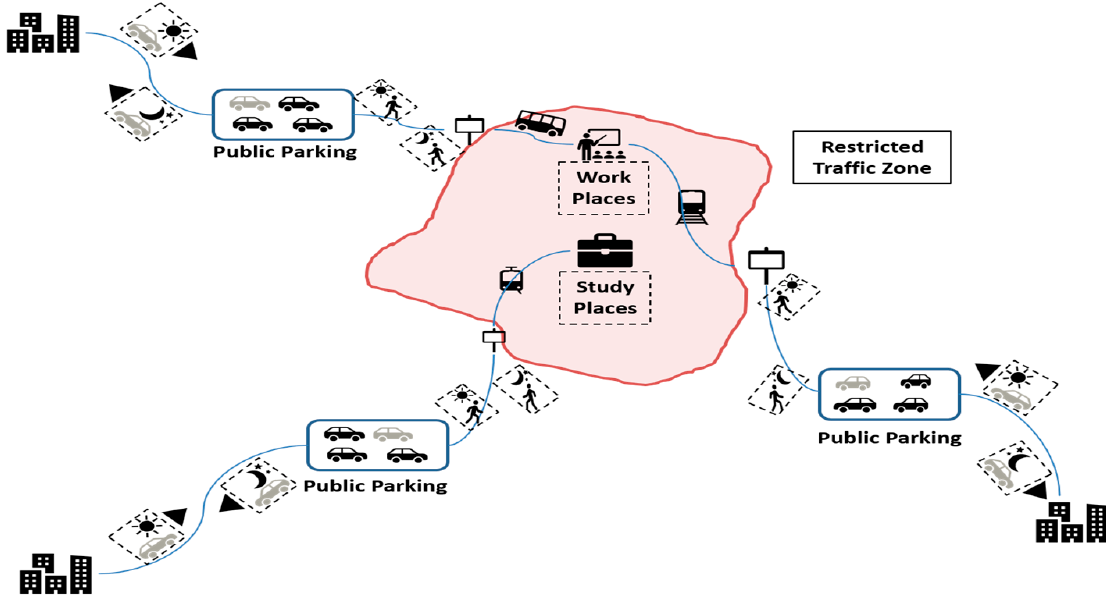
Figure 3. Using public transport systems by the commuters with private vehicles who work or study in the restricted traffic zones.